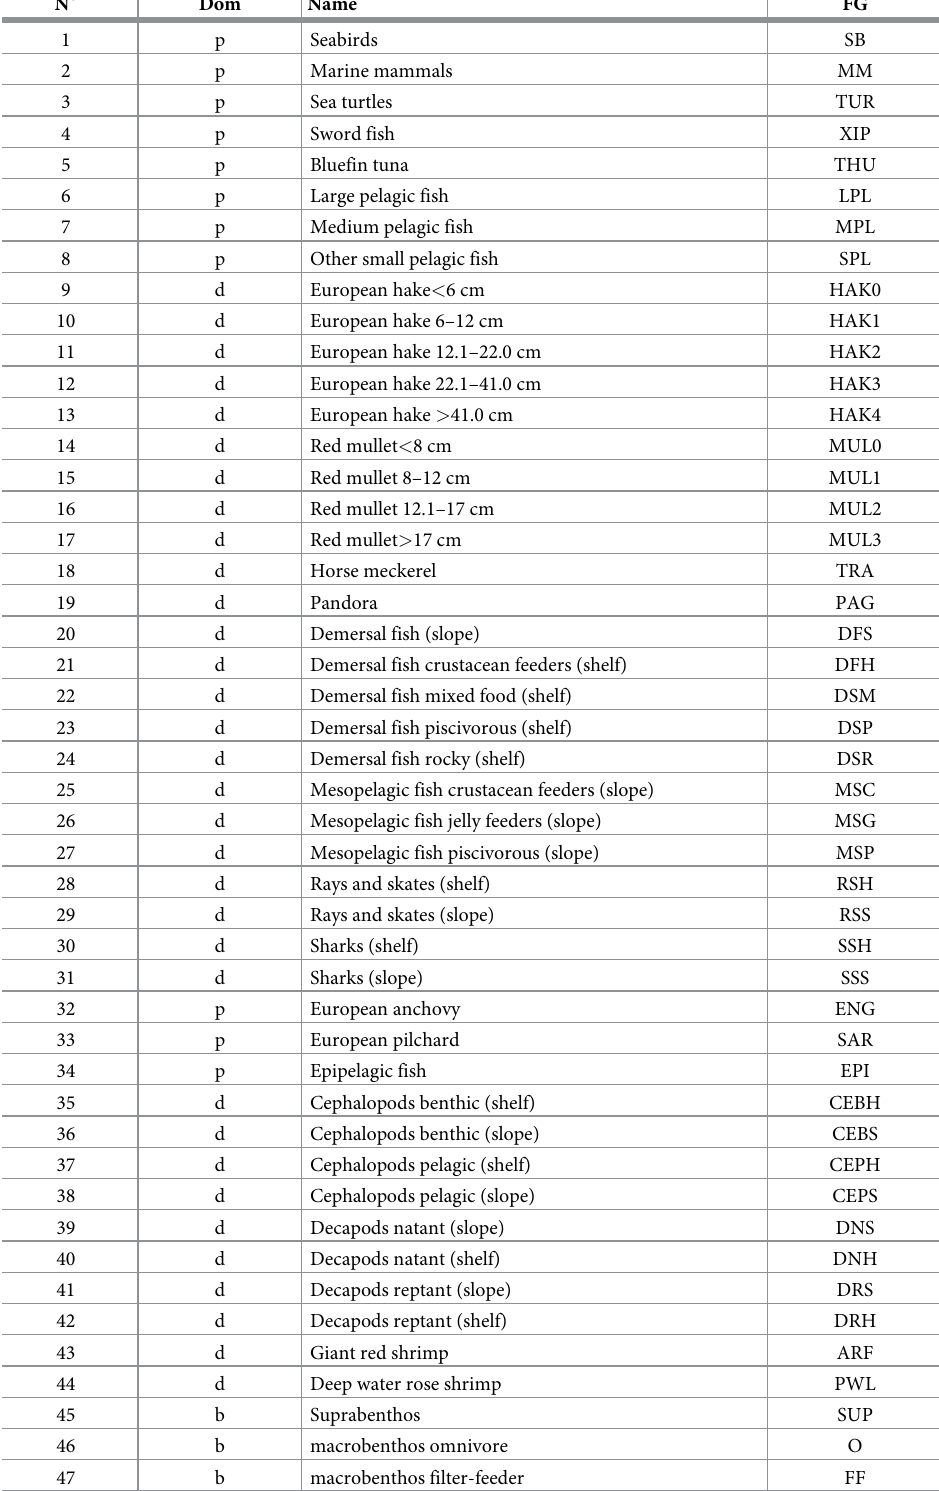
Table 2. Summary description of 72 biological functional